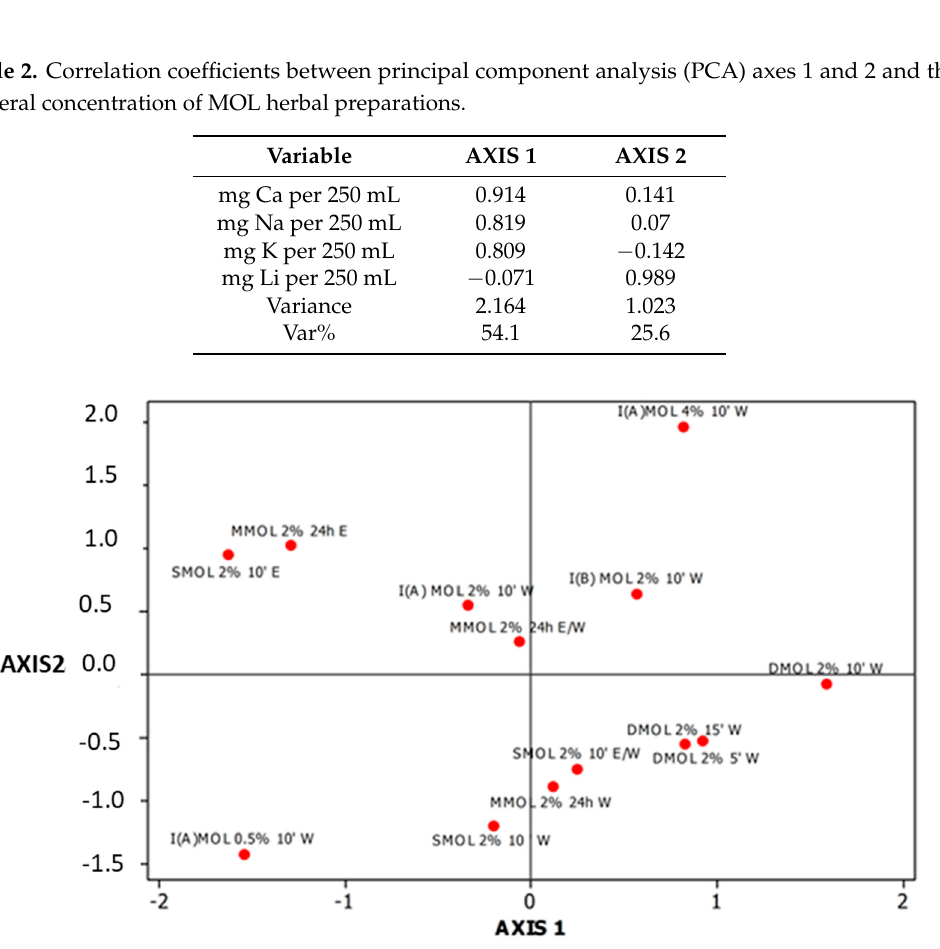
Figure 4. Arrangement of MOL herbal preparations according to the scores produced by the PCA technique based on Na, K, Ca and Li data. Table 2 shows the contribution of each of the four studied variables (Na, K, Ca, Li) with each axis.